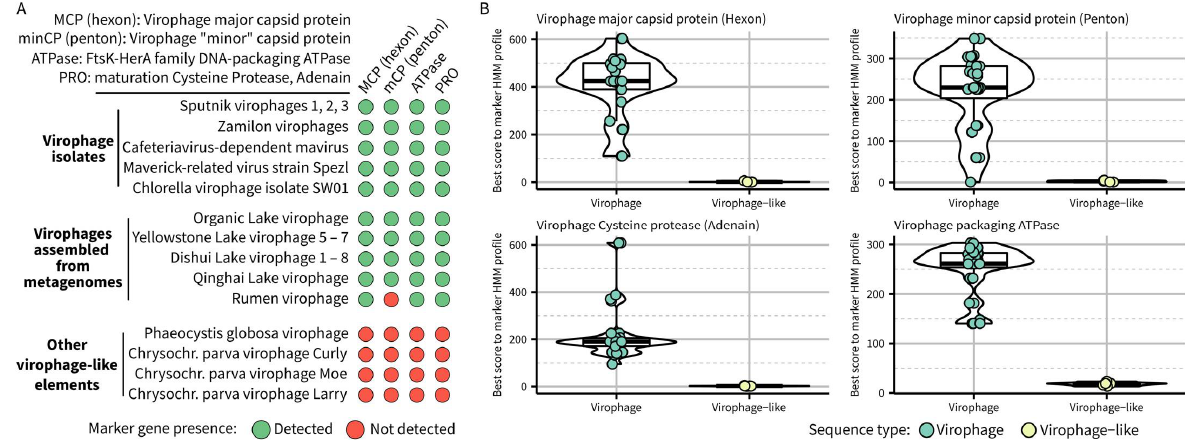
Figure 1. Detection of virophage marker genes across sequences currently classified in the Lavidaviridae family on GenBank. Marker genes were detected based on an hmmsearch performed between predicted proteins from the Lavidaviridae genomes and HMM profiles previously built for the four conserved genes in the virophage morphogenesis gene module [12]. Panel ( A ) displays the pattern of conserved gene detection for virophage isolates, virophage genomes assembled from metagenomes, and virophage-like elements currently classified as Lavidaviridae on GenBank but not encoding any of the virophage conserved genes. Panel ( B ) displays the distribution of the hmmsearch score for each marker for both the virophages (isolates or assembled from metagenomes) and the virophage-like elements. Accession numbers for the different genomes used here are indicated in Table S1.